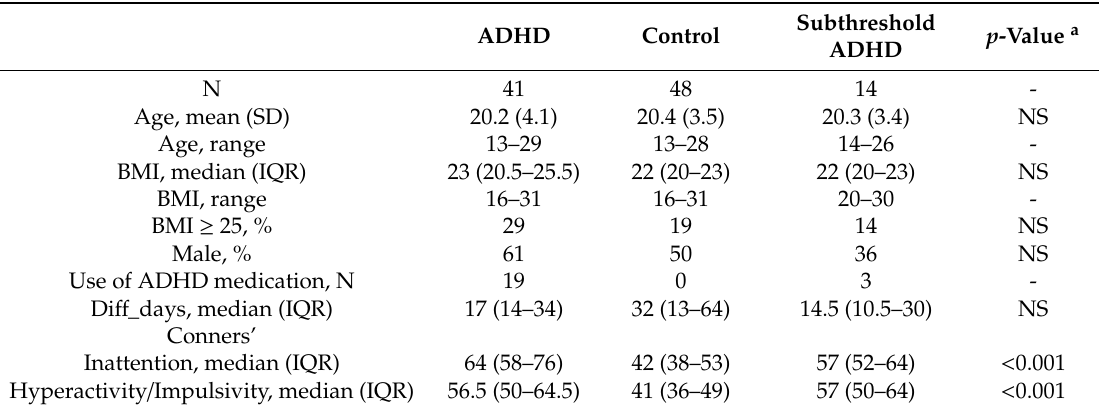
Table 1. Characteristics of the